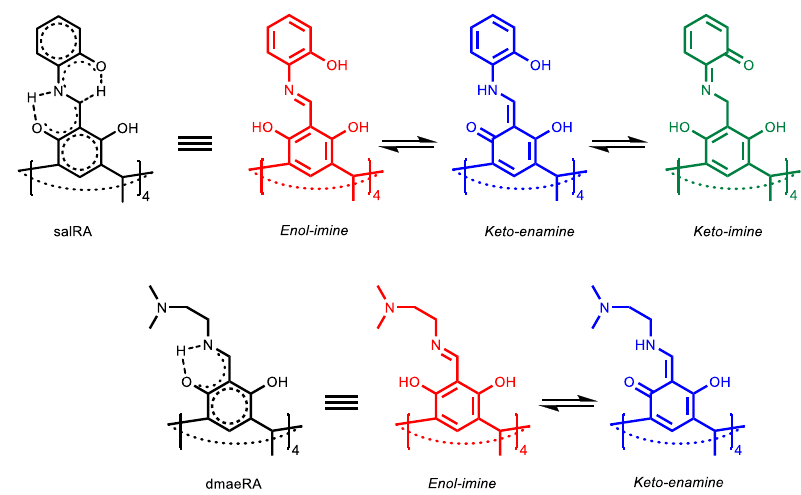
Scheme 2. Tautomers of salRA and dmaeRA.